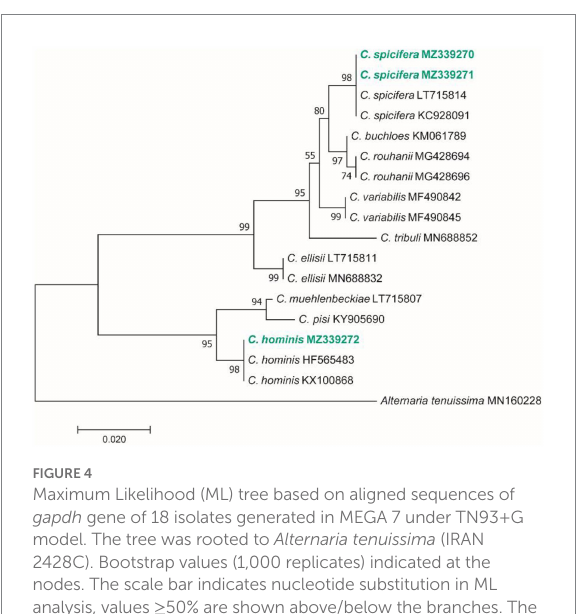
FIGURE 5 Maximum Likelihood (ML) tree based on aligned sequences of tef-1 α gene of 23 isolates generated in MEGA 7 under K2 + I model. The tree was rooted to Nectria illudens (NRRL 22090). Bootstrap values (1,000 replicates) indicated at the nodes. The scale bar indicates nucleotide substitution in ML analysis, values ≥ 50% are shown above/below the branches. The surveyed isolates in the current study are highlighted in